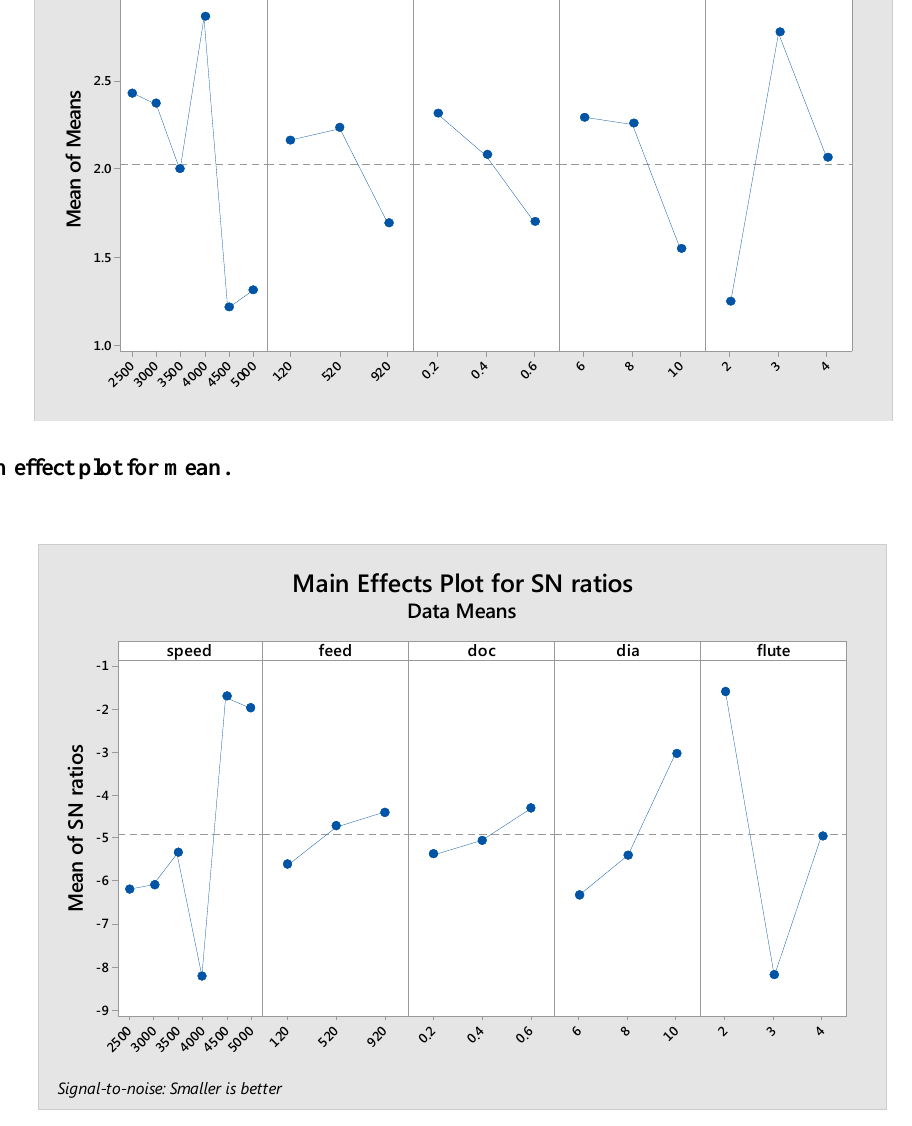
The effect of combination parameters and